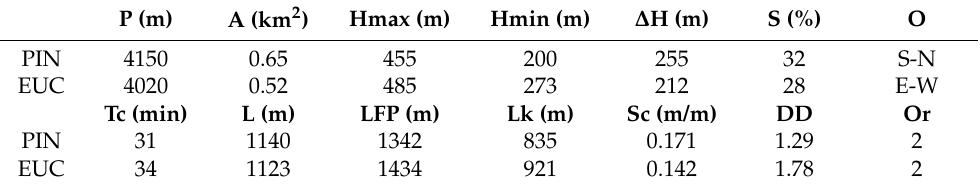
Table 1. Main topographic characteristics of the two study catchments: Lourizela (PIN) and Serra de Cima (EUC) covered mainly by Pinus pinaster Aiton and Eucalyptus globulus Labill., respec-